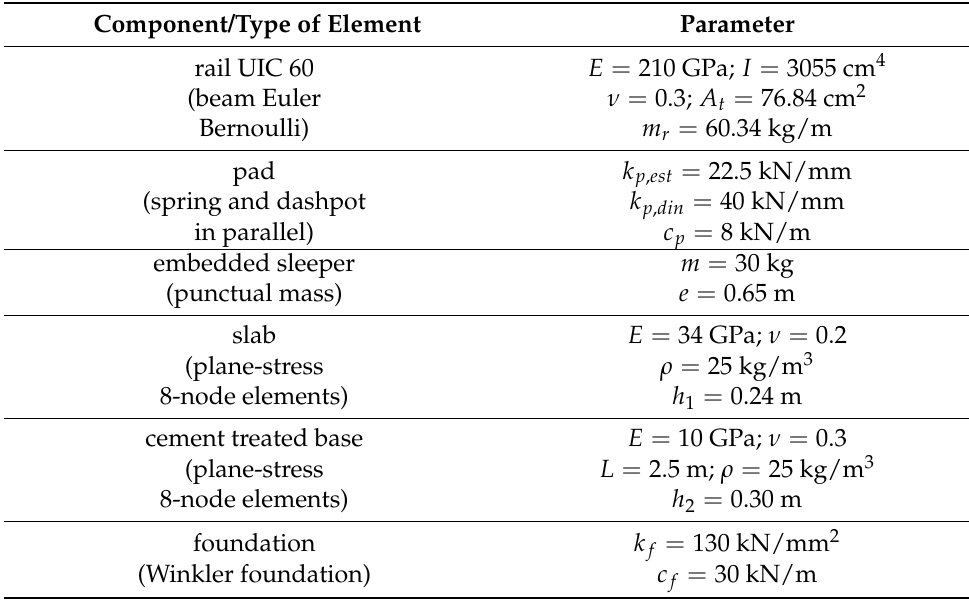
Table 2. Geometrical and mechanical characteristics of the slab track components.